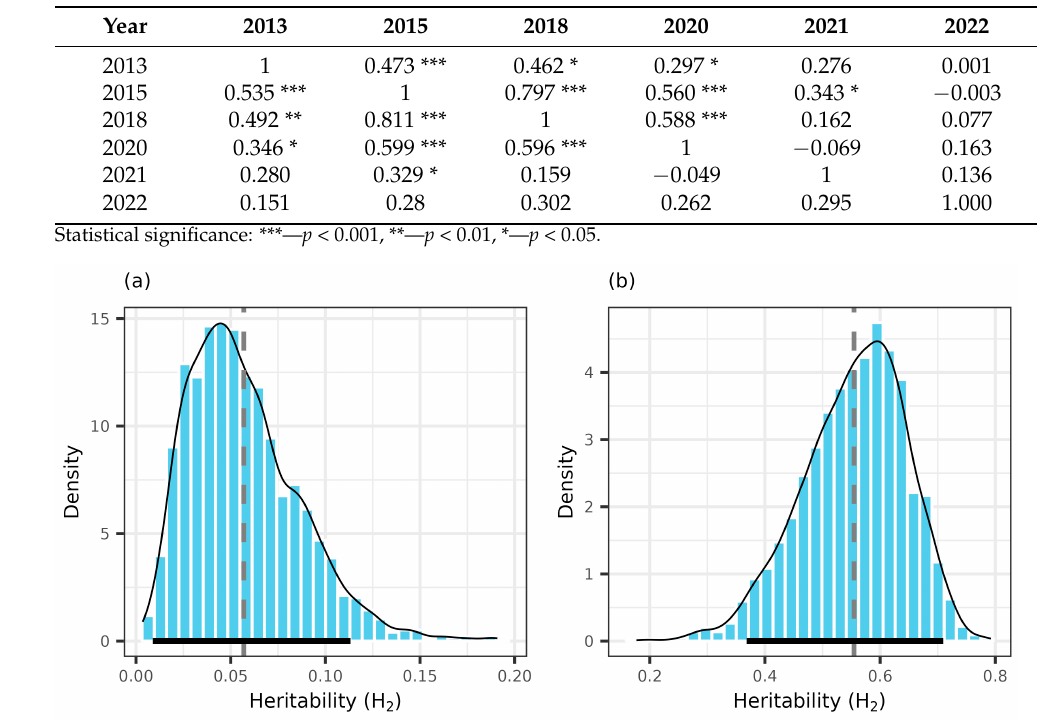
Figure 2. Posterior MCMC samples (bars), kernel density estimation (thin solid line), posterior mean (dotted line), and 95% credible intervals (thick solid line) of heritability in zero-inflated ( a ) and Poisson ( b ) components of cone crops. Estimates are in data scale.